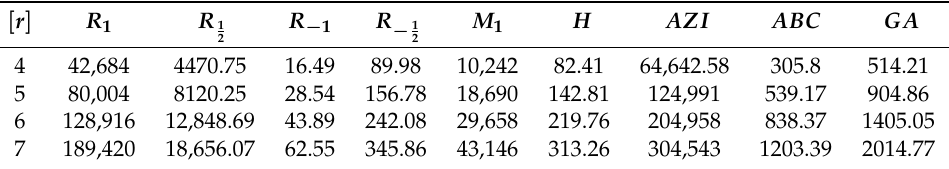
Table 5. Numerical computation of all indices for HDN 3 ( r )